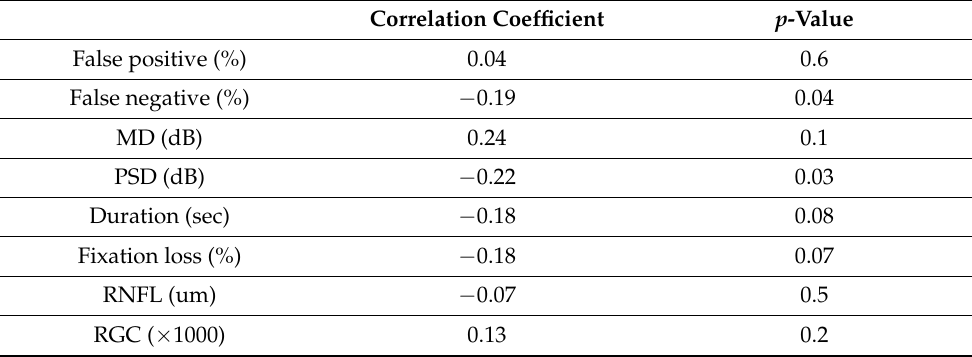
Table 3. The association between MoCA Scores and visual field reliability and structure–function measures (all eyes